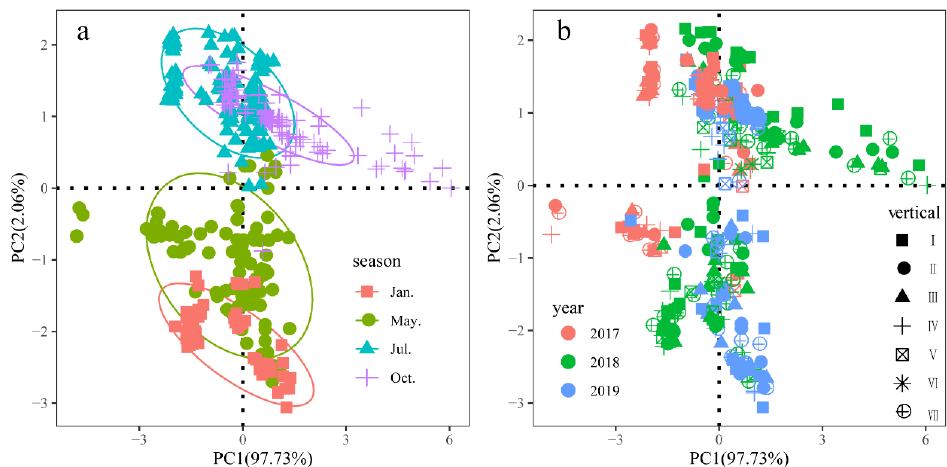
Figure 2. PCA of vertical water environmental factors in the Danjiangkou Reservoir (( a ): Season; ( b ) Vertical).